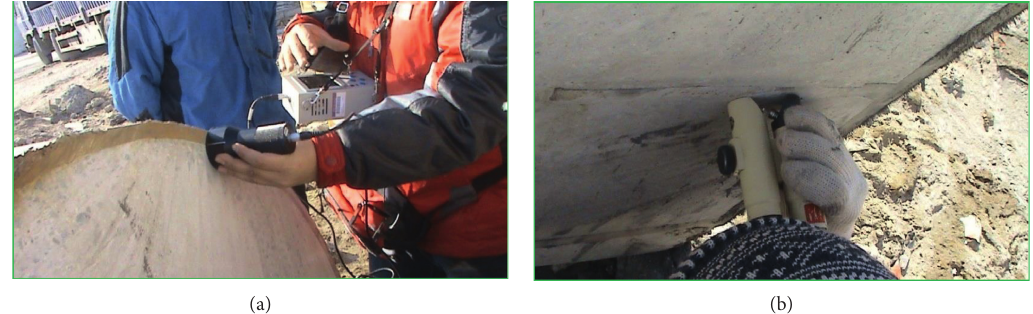
Figure 10: Detection of cracks between steel tube wall and the core concrete. (a) Detecting by electronic crack observer. (b) Detecting by visual crack